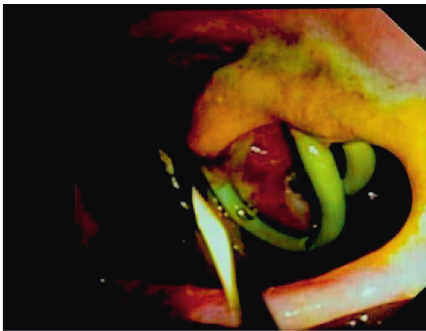
Figure 9: Drainage catheter in the lumen of the duodenum.